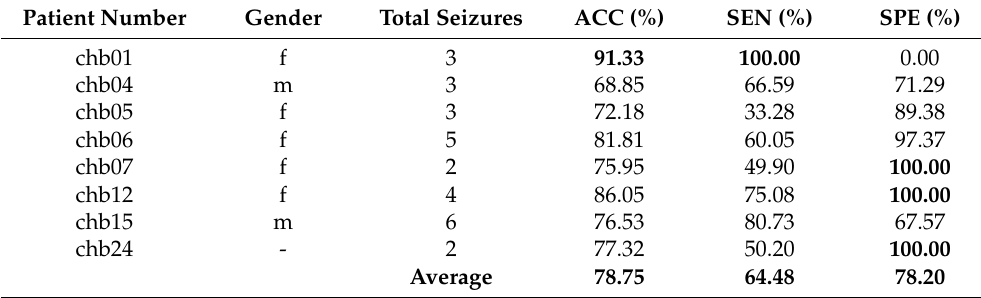
Table 1. RCV results for the CHB-MIT data set. Bold format highlights maximum values.